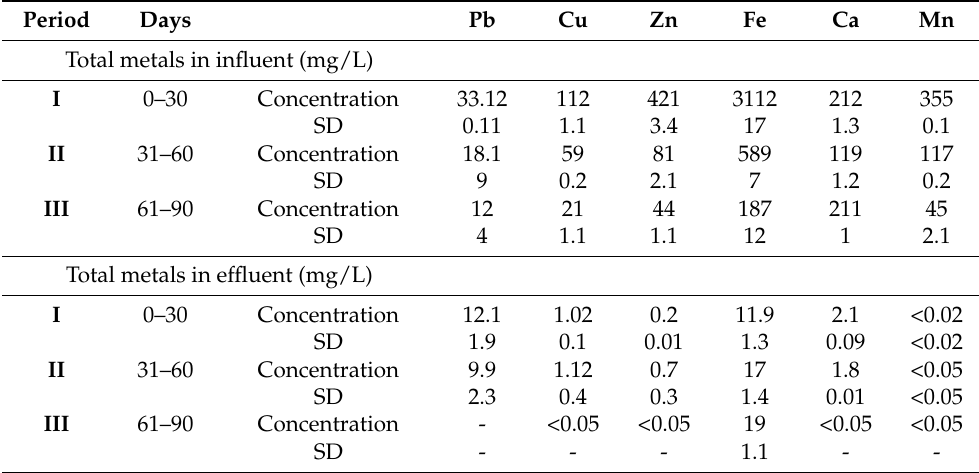
Table 3. Metal concentrations removal and standard deviation